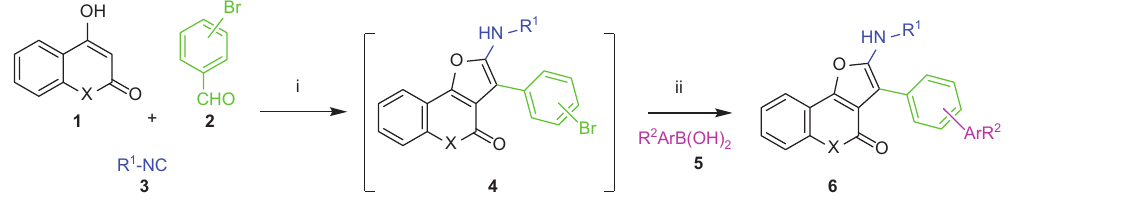
Table 2 One-pot synthesis of furocoumarin and furoquinolone derivatives 6